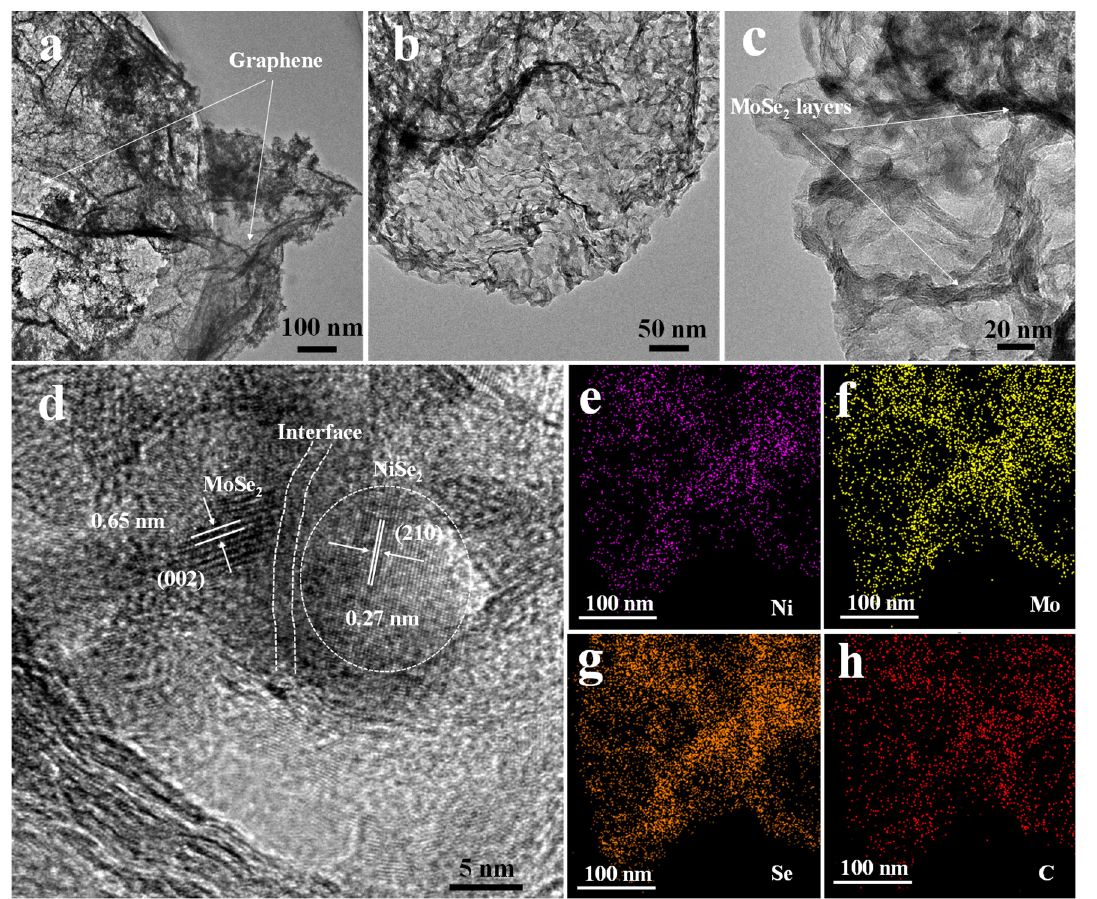
Figure 4. ( a – c ) TEM images of NiSe 2 -MoSe 2 HTs/G composite. ( d ) High-resolution TEM (HRTEM) images of NiSe 2 -MoSe 2 HTs/G. ( e – h ) EDS elemental mapping images of NiSe 2 -MoSe 2 HTs/G. The NiSe 2 , MoSe 2 , NiSe 2 -MoSe 2 HTs, NiSe 2 -MoSe 2 HTs/G, and Pt-C samples were